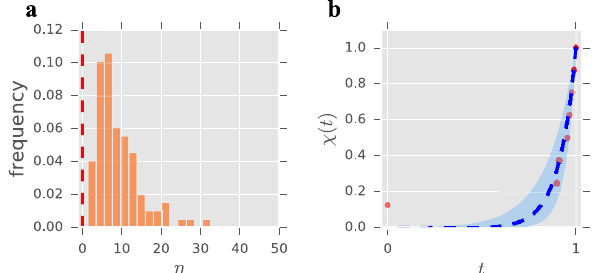
Figure 4. Summary of the results for the face-to-face contacts dataset. ( a ) Distribution of the parameter estimates for the face-to-face contacts dataset ( n = 95 ). The red, dashed line marks the change of regime ( η = 0 ); mean = 9.08 , median = 7.35 , mode = 5.54 , std = 5.86 . ( b ) Representative fitting for an individual in the face-to-face contacts dataset (chosen at random from those with a strictly positive 95% confidence interval). Solid dots represent experimental data, blue dashed lines represent the graph of Eq. (9) with the corresponding estimated parameter, and shaded regions show the 95% confidence interval for that estimate (see “Bayesian estimate of the scaling parameter” section). Estimated η = 11.12 , 95% confidence interval (6.74, 18.34), ˜ L = 15